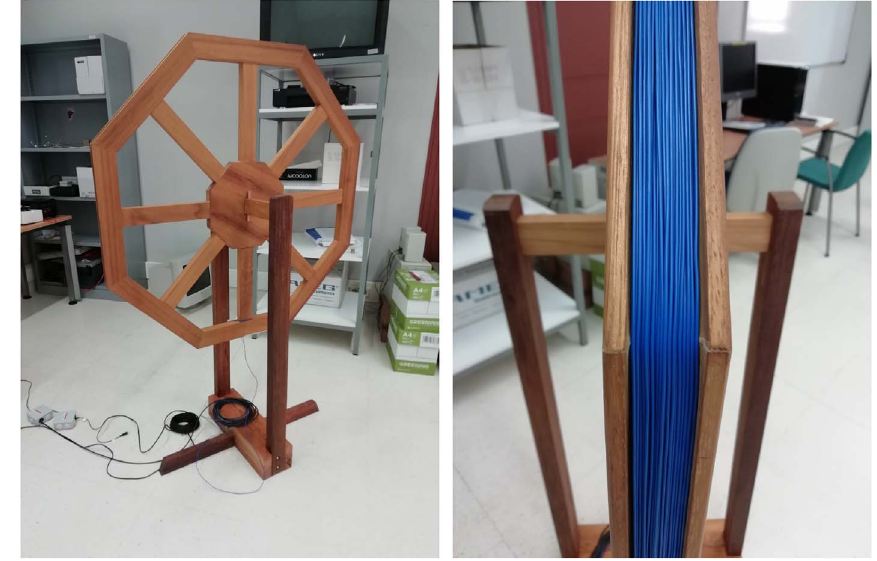
Fig. 1. Antenna structure with an octagon shape (left) and coil winding (right).